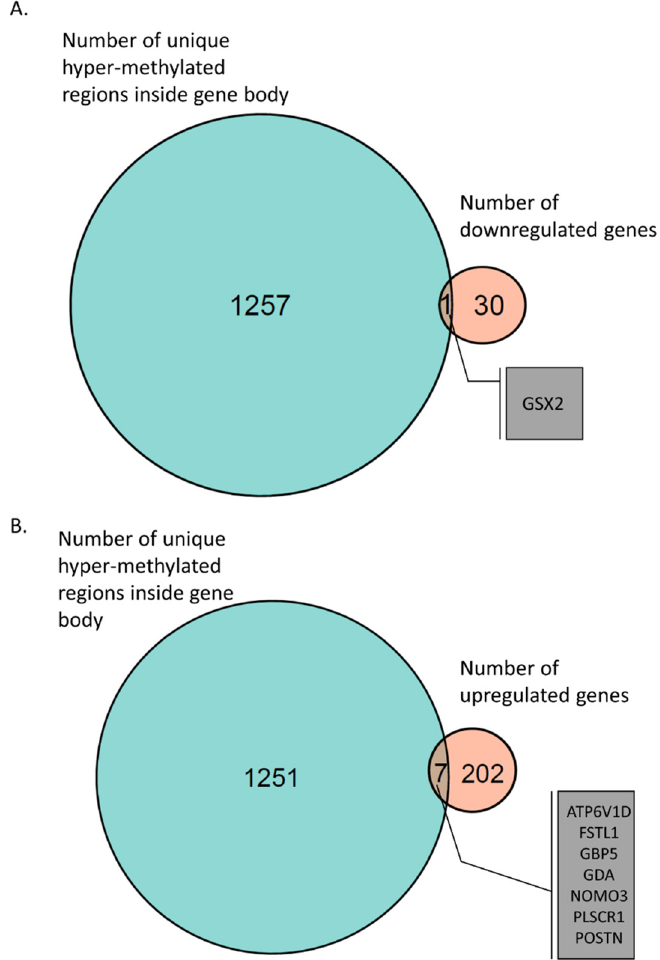
Figure 4. Venn diagram of gene-body hyper-methylation and gene expression. ( A ) GSX2 gene, which had a hyper-methylated region inside its gene body and was found to be downregulated in AS-derived iPSC neurons. ( B ) Seven genes were identified with hyper-methylated regions inside their gene bodies and were found to be upregulated in AS iPSC-derived neurons.